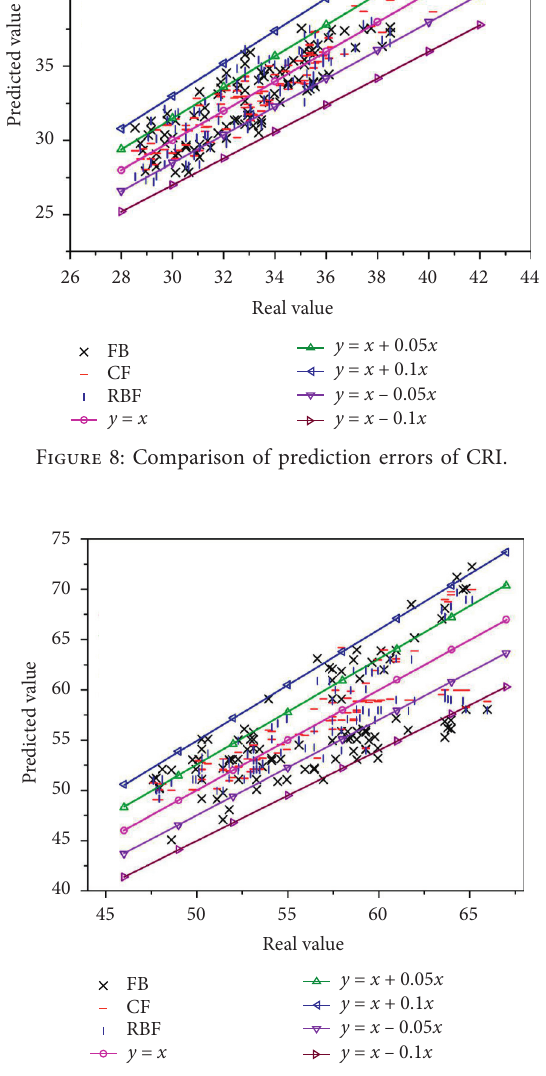
Figure 9: Comparison of prediction errors of t , d .